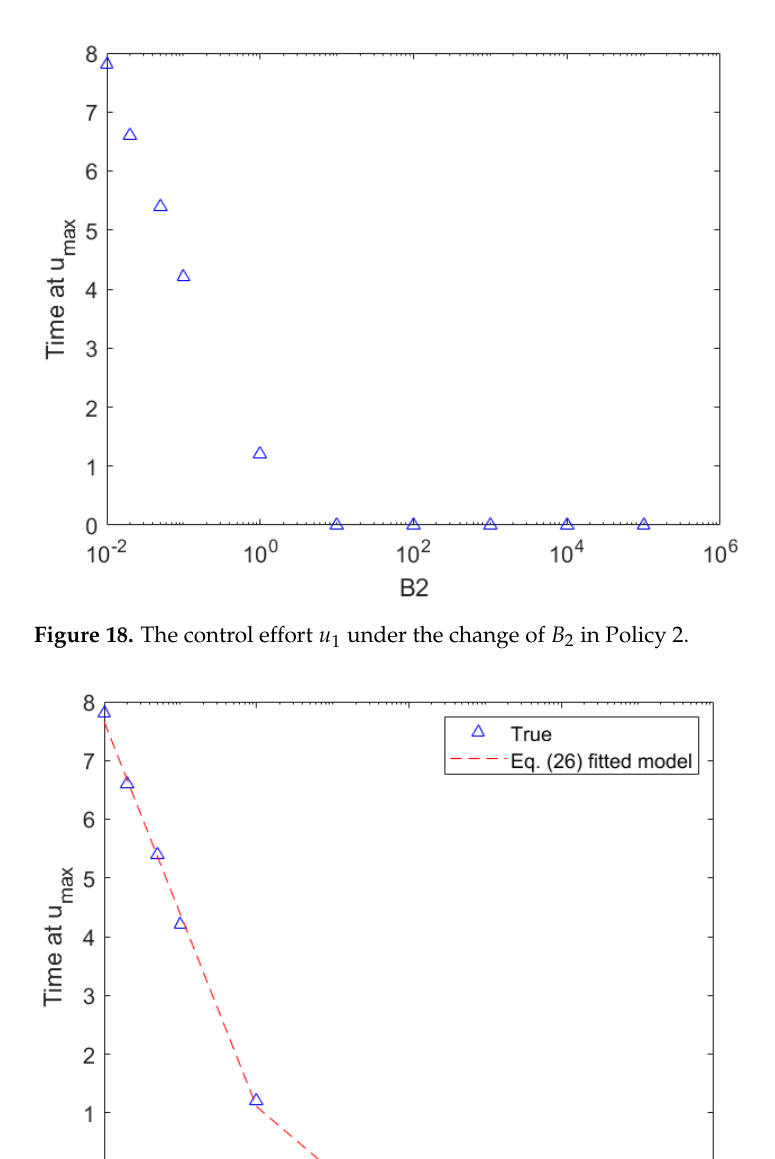
Figure 19. The time required for control signal u ( t ) to stay at its maximum, t max , against the parameters of Equation (23).